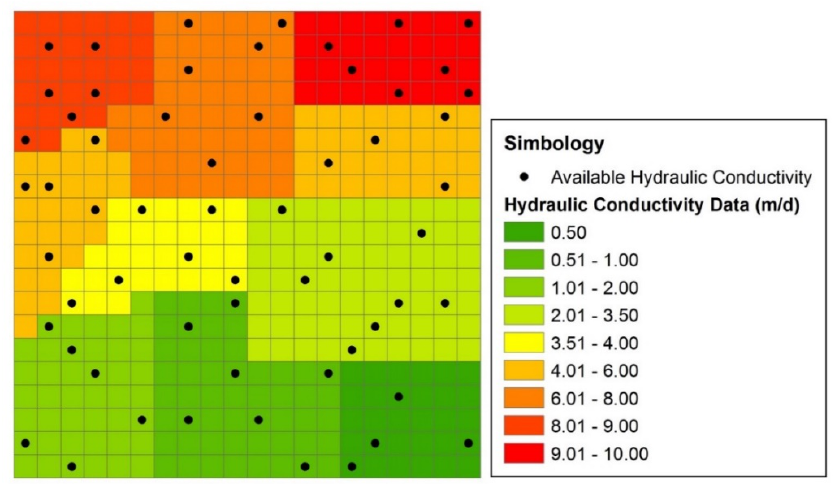
Figure 2. Spatial distribution of hydraulic conductivity data (m/day) for the numerical flow model. Table 5. Parameters of the fitted variogram models.